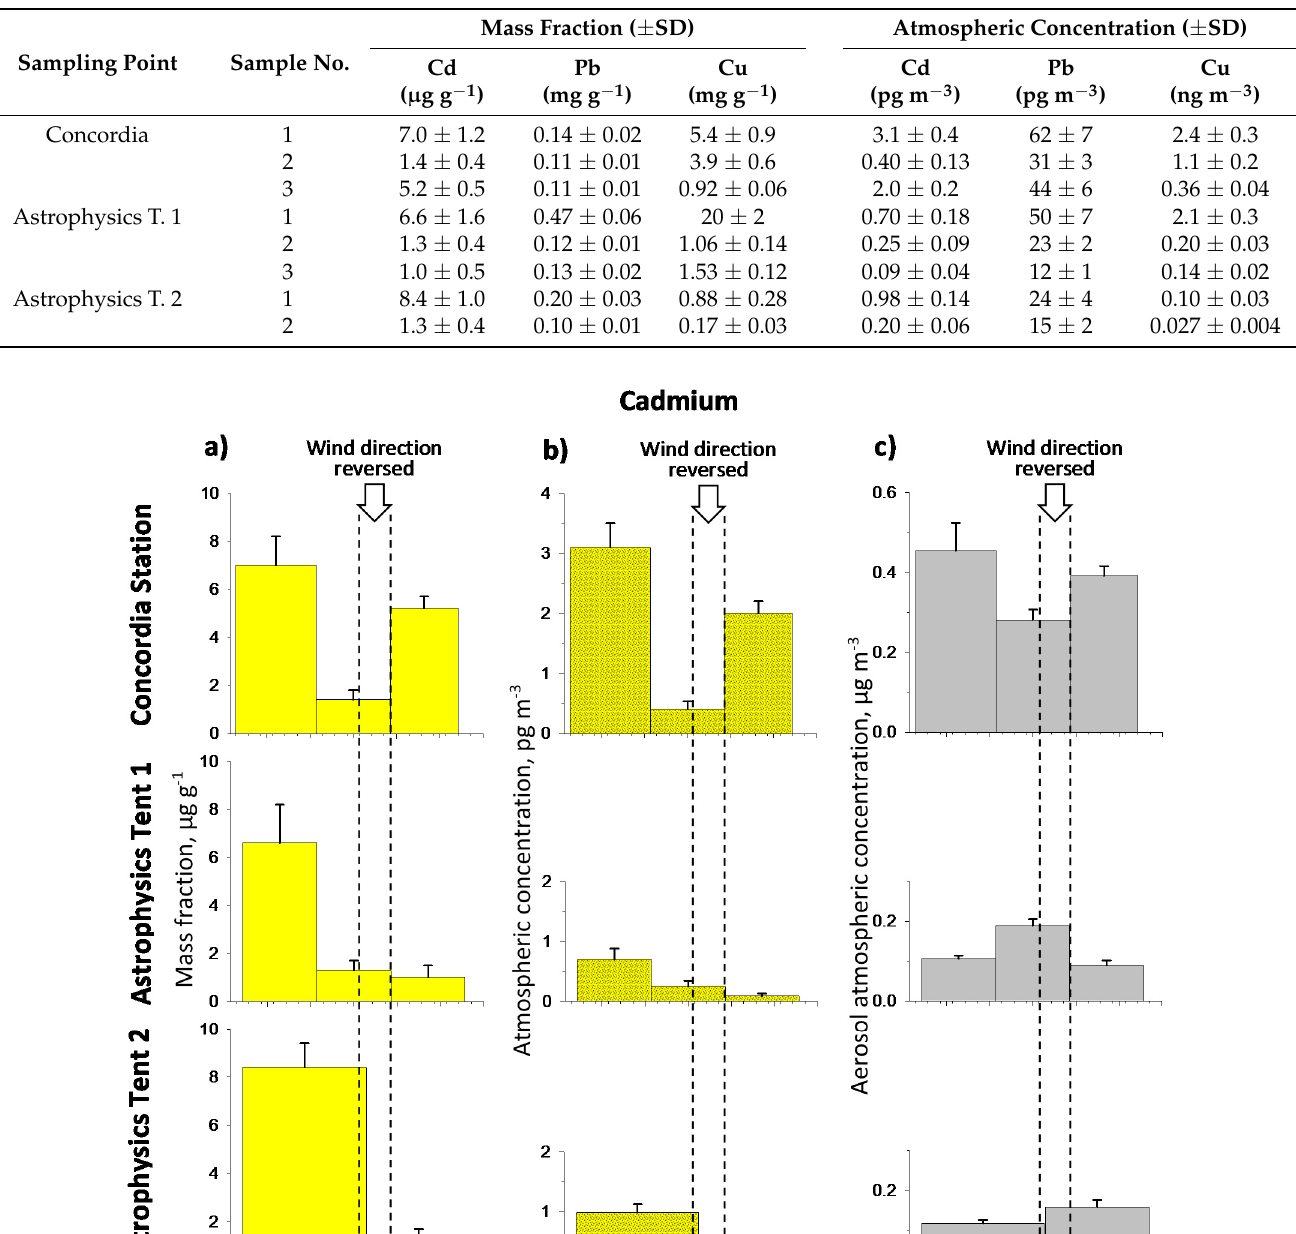
Table 1. Cd, Pb, and Cu in Antarctic aerosol expressed as metal mass fraction and metal atmospheric concentration ( ± standard deviations from 3–6 measurements). Dome C, Concordia Station, austral summer 2005–2006. Atmospheric concentrations refer to standard air (298 K, 760 mmHg).